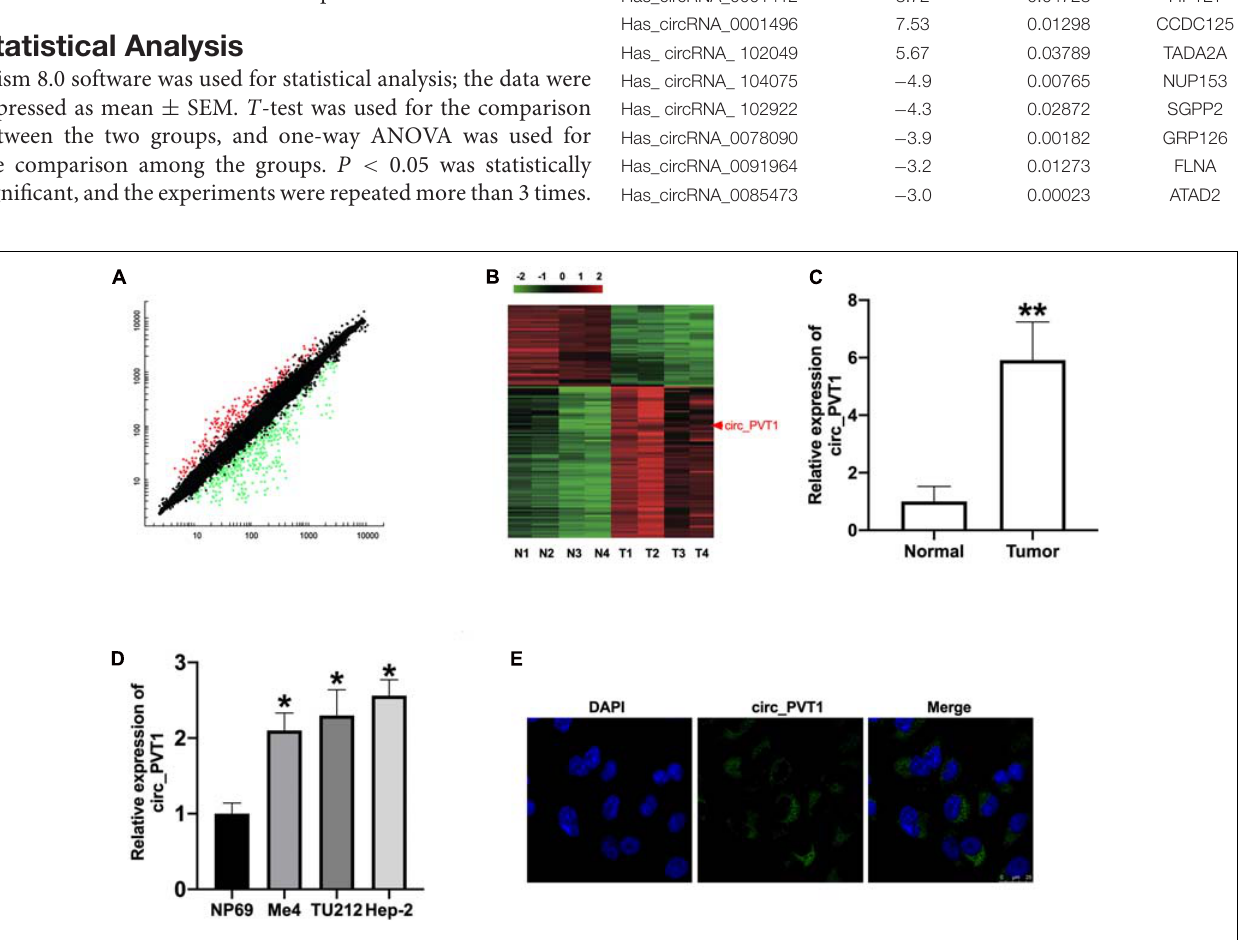
Frontiers in Cell and Developmental Biology |